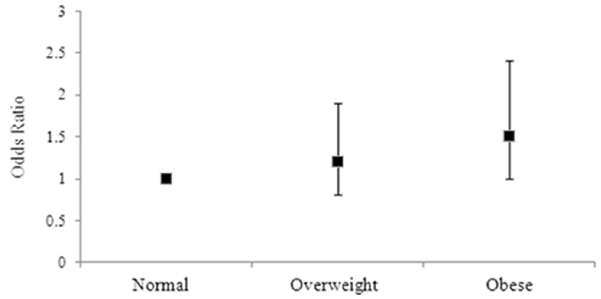
Figure 2. Adjusted odds ratios for men with EDS for BMI groups. Error bars represent the 95% CI. Group 1 (ideal BMI) is the reference group, with a broken line indicating the threshold of